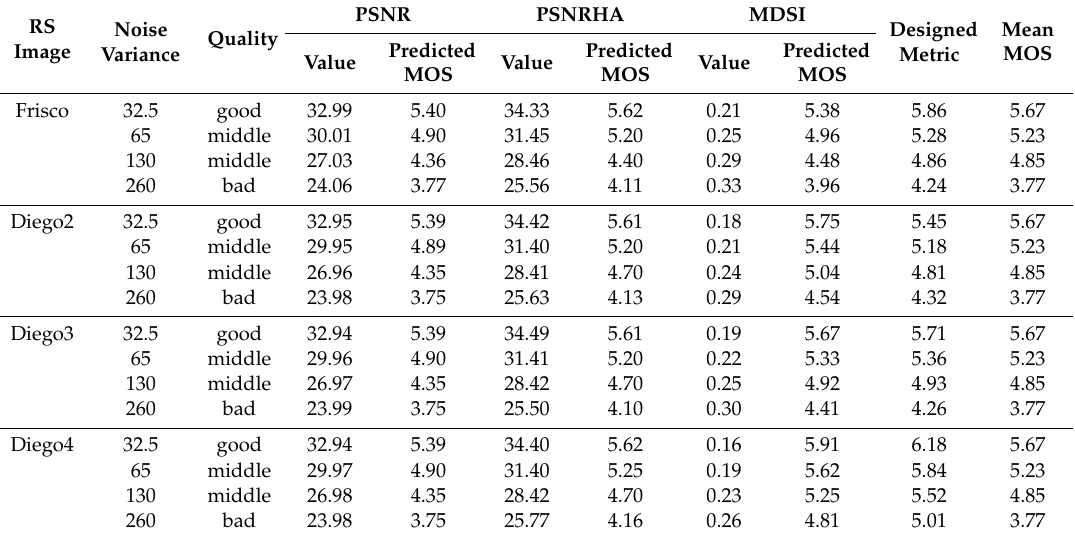
Table 10. Predicted MOS values for four RS test images distorted by an additive white Gaussian noise. RS